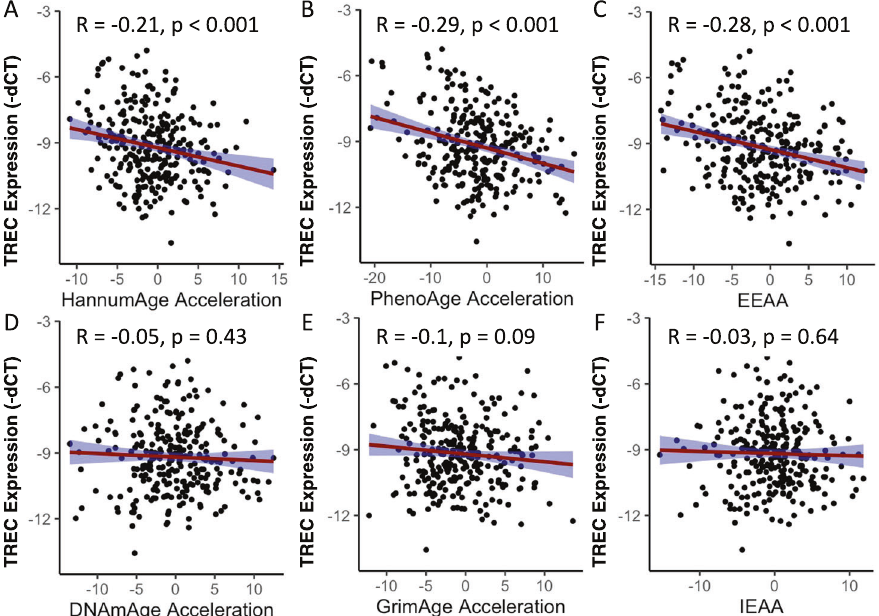
Fig. 4 Associations between TREC levels and measures of epigenetic age acceleration in humans (men and women). Note that TREC data are depicted as -dCT to clarify that higher dCT integer values indicate lower levels of TRECs. Levels of TRECs were negatively correlated with A HannumAge acceleration, B PheonAge acceleration and C extrinsic epigenetic age acceleration (EEEA). TREC levels were not correlated with D DNAmAge acceleration, E GrimAge acceleration, or F intrinsic epigenetic age acceleration (IEAA). N = 276. CD4T and CD8T cells. We identi fi ed 9 CpG sites associated with levels of TRECs in CD8T cells, and 2 CpG sites in CD4T cells (FDR < 0.05) (Fig. 5). There was no overlap between signi fi cant sites observed in CD8T and CD4T cells. In women, TREC levels associated with 17 CpG sites in CD8T cells and 2 CpGs in CD4T cells (FDR < 0.05) (Supplemental Fig. 8, [Inset] Supplemental